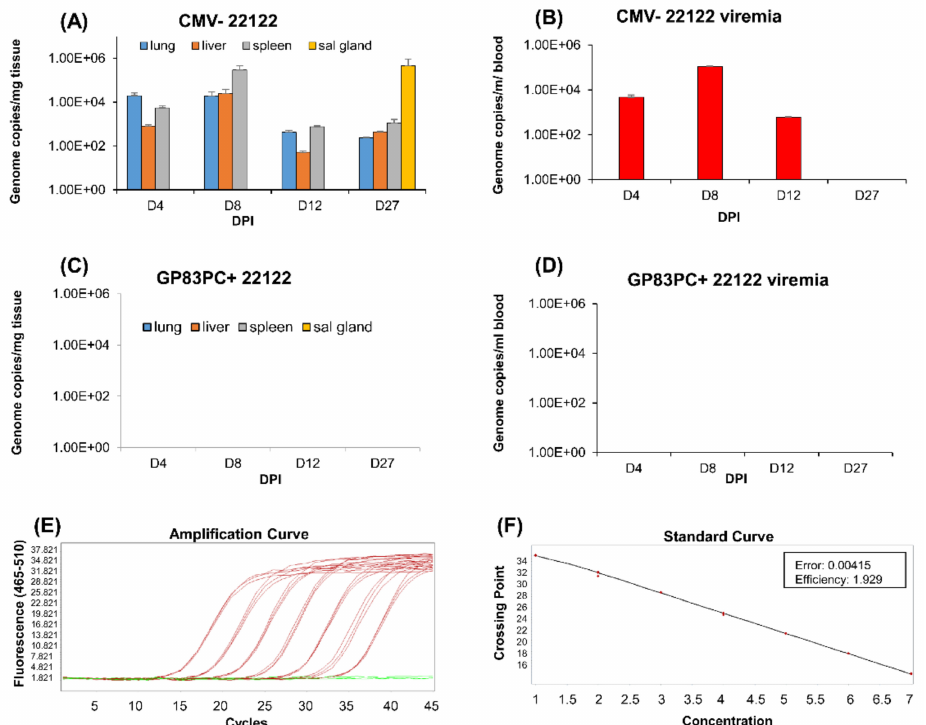
Figure 5. Comparative dissemination of GPCMV to target organs in seronegative and GP83dPC+ vaccinated animals. Seronegative animals, ( A , B ), and GP83dPC+seropositive animals, ( C , D ) ( n = 12 per group), were challenged with wt GPCMV (10 5 PFU). At various days (4, 8, 12, and 27 dpi), 3 animals per group were evaluated for the viral load in the target organs by real-time PCR of DNA extracted from tissues, ( A , C ). Mean viral load is plotted as the number of viral genome copies/mg tissue. Salivary gland (sal gland) tissue was evaluated only at day 27. Mean viremia at 4, 8, 12, and 27 dpi plotted as the number of genome copies/mL blood ( B , D ). The target organs were lung, liver, spleen, salivary gland, and blood. Experiments carried out in triplicates in minimum of two independent assay runs. Representation of real-time PCR standard amplification, ( E , F ). A known concentration of GPCMV GP44 plasmid DNA was diluted 10-fold and run in triplicate, as stated in Materials and Methods, to generate the amplification curve ( E ) and the standard curve ( F ). The red lines indicate positive amplification; the green lines indicate the negative no-template